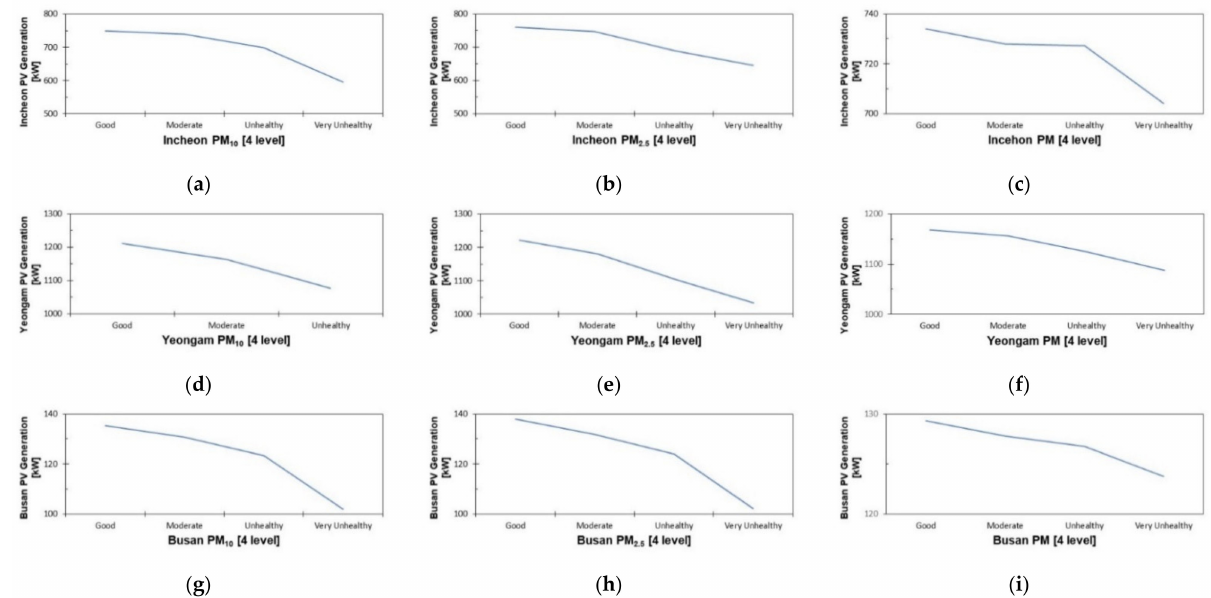
Figure 6. The reduction rates of solar PV generation according to particulate matter (PM): ( a ) The reduction rates in Incheon (KMA PM 10 ); ( b ) The reduction rates in Incheon (KMA PM 2.5 ); ( c ) The reduction rates in Incheon (NMSC PM); ( d ) The reduction rates in Yeongam (KMA PM 10 ); ( e ) The reduction rates in Yeongam (KMA PM 2.5 ); ( f ) The reduction rates in Yeongam (NMSC PM); ( g ) The reduction rates in Busan (KMA PM 10 ); ( h ) The reduction rates in Busan (KMA PM 2.5 ); ( i ) The reduction rates in Busan (NMSC PM).